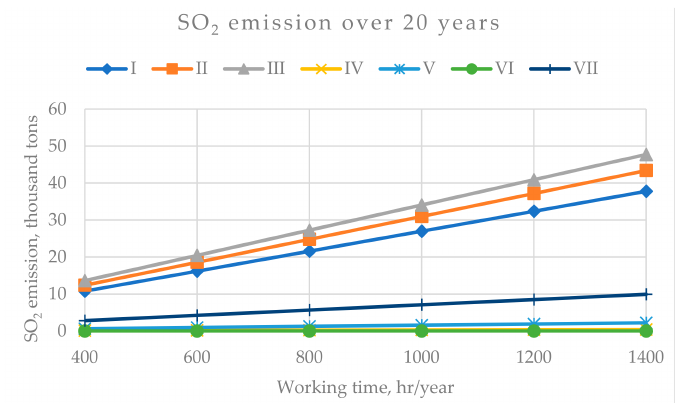
Figure 6. SO 2 emission of individual heating systems for the system operation time of 400 to 1400 h